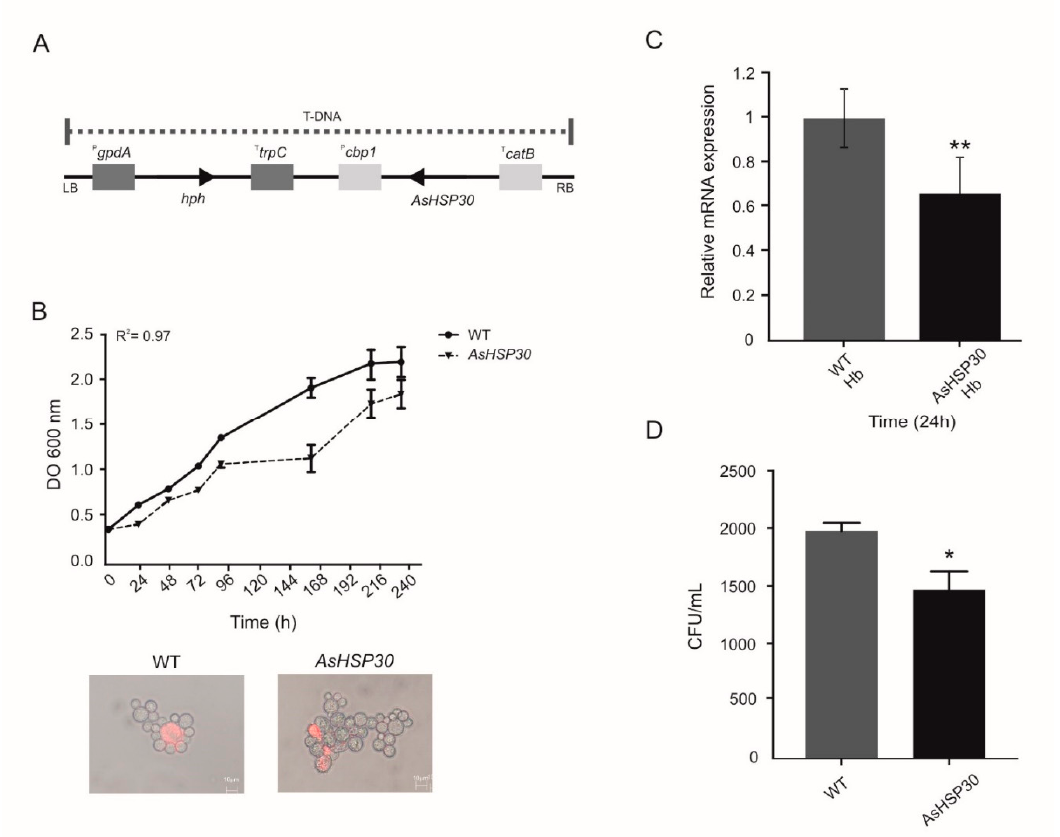
Figure 5. HSP30 silencing in P. brasiliensis cells. ( A ) Integration DNA cassette scheme. The asRNA of Pb HSP30 was flanked by the calcium-binding protein promoter region ( P cbp1 ) of Histoplasma capsulatum and by the cat-B termination region ( T catB ) of Aspergillus fumigatus . The hygromycin resistance gene used as a selection mark was flanked by the glyceraldehyde-3- phosphate dehydrogenase promoter region ( P gapdA ) and the trpC termination region ( T trpC ) of Aspergillus nidulans . ( B ) Growth and viability of P. brasiliensis strains. Yeast cells of WT and AsHSP30 were grown in liquid Brain Heart Infusion (BHI) medium for 10 days and the OD was measured daily at 600 nm. Cellular viability was examined by propidium iodide staining. ( C ) Transcriptional analysis of WT and AsHSP30 strain in the presence of hemoglobin. The strains were grown in liquid BHI medium for 72 h and subsequently in MMcM medium containing hemoglobin. The relative mRNA expression was evaluated at 24 h. ( D ) Number of WT and AsHSP30 CFUs recovered after growth in the presence of hemoglobin. After culturing in the presence of hemoglobin, WT and AsHSP30 cells were plated in solid BHI medium and the colony forming units were counted after 7 days. GraphPad Prism software (GraphPad Software, Inc., La Jolla, CA, USA) was used for statistical analysis and Student’s t-test was applied considering p values ≤ 0.05 statistically significant. (*, **) denotes statistically significant